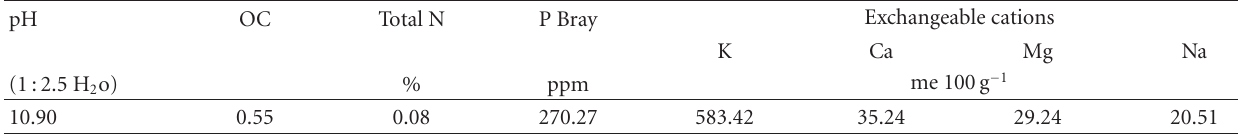
Table 2: Chemical properties of the palm bunch ash used in the experiment.